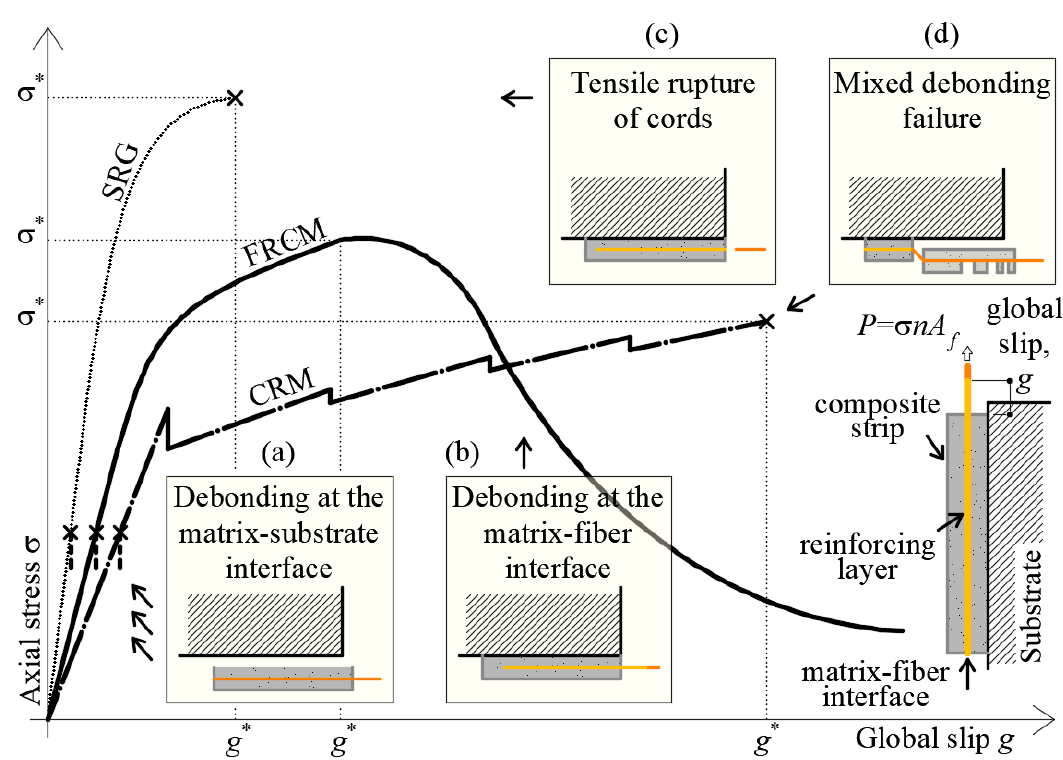
Figure 3. Representative axial stress–global slip responses of inorganic-matrix reinforcement-substrate joints subjected to direct shear single-lap test (typical failure modes are illustrated in boxes). σ * = peak axial stress; g* = global slip associated with σ* .